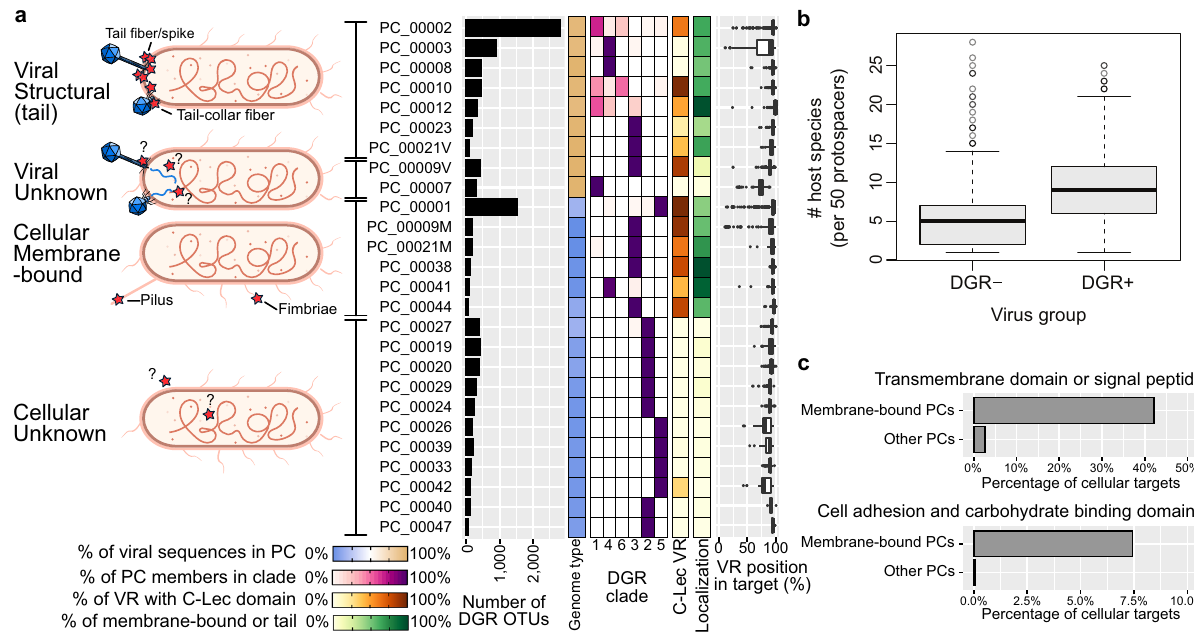
Fig. 2 Diversity and major types of DGR targets. a Prevalence and sequence characteristics of the most abundant DGR target protein clusters (PCs). The 24 PCs listed here represent >92% of all identi fi ed DGR targets. These were divided into four major types (left panel; predicted localization of target proteins highlighted with red stars). Characteristics of each PC are indicated to the right, including a number of associated DGR RT OTUs, the relative proportion of viral-encoded vs. cellular-encoded DGRs ( “ Genome type ” ), distribution across DGR clades, percentage of PC member with a detected C-Lec fold around the VR region, percentage of PC members predicted as a tail structural protein (for viral targets) or membrane protein (for cellular targets), and relative position of the VR region within the target sequence. The boxplot lower and upper hinges correspond to the fi rst and third quartiles, respectively, and the whiskers extend no further than ±1.5 times the interquartile range. For C-Lec fold VR and localization prediction data, only high-quality targets were considered (see “ Methods ” ). For mixed PCs (PC_00009 and PC_00021), targets with an unknown origin were excluded. b Estimated host diversity for viral genomes encoding (DGR + , n = 822) or lacking DGRs (DGR − , n = 1182) matching at least 50 CRISPR spacers. The vertical axis shows the number of connected host species per 50 protospacers. The boxplot lower and upper hinges correspond to the fi rst and third quartiles, respectively, and the whiskers extend no further than ±1.5 times the interquartile range. c Percentage of cellular targets with a predicted transmembrane domain (top) or one or more functional domain(s) associated with cell adhesion and/or carbohydrate-binding identi fi ed outside of the VR region (bottom). Target sequences are divided based on their PC membership into “ membrane-bound ” PCs or “ other ” PCs (see panel ( a